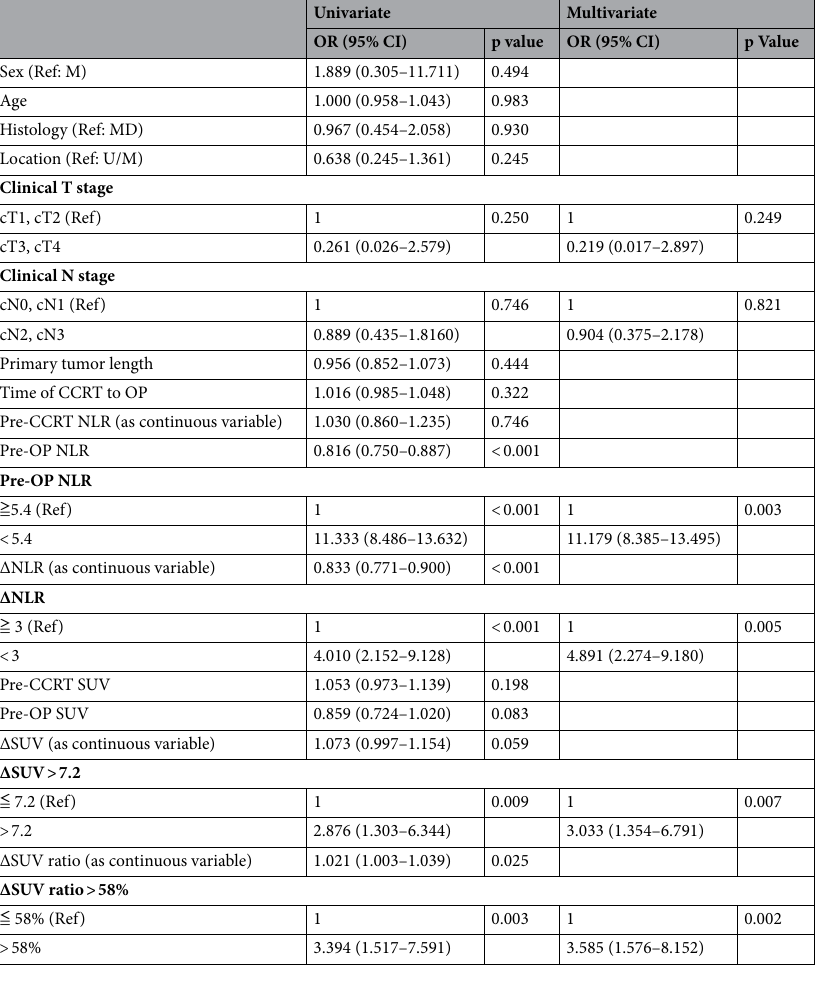
Table 2. Results of univariate and multivariate analyses based on logistic regression on pCR. OR odds ratio, 95% CI 95% confidence interval, M male, MD moderately differentiated, U upper thoracic, M middle thoracic,